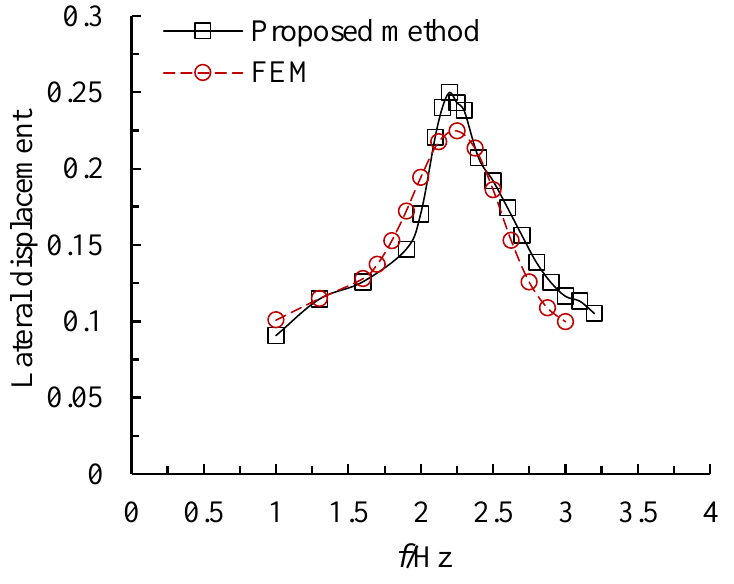
Figure 8. Comparison of the lateral dynamic response atop the GBF at different frequencies.